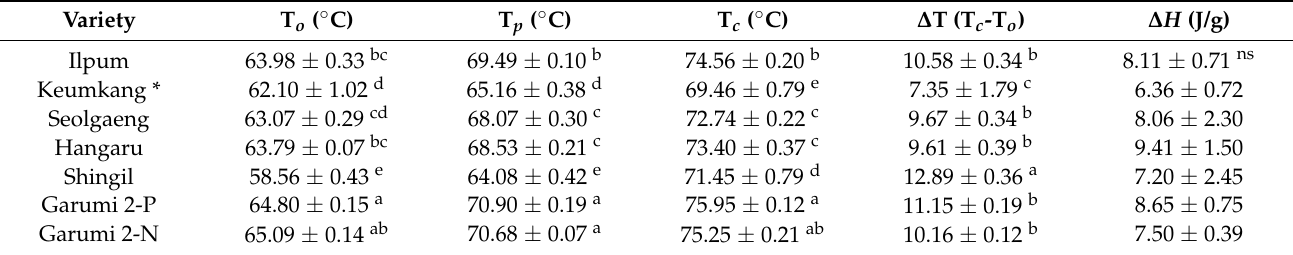
Table 3. DSC characteristics of flours obtained from different varieties of